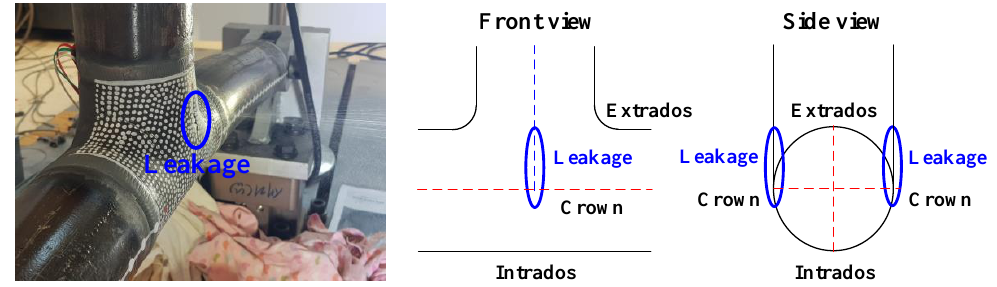
Figure 3. Position of the leakage caused by a through-wall crack.